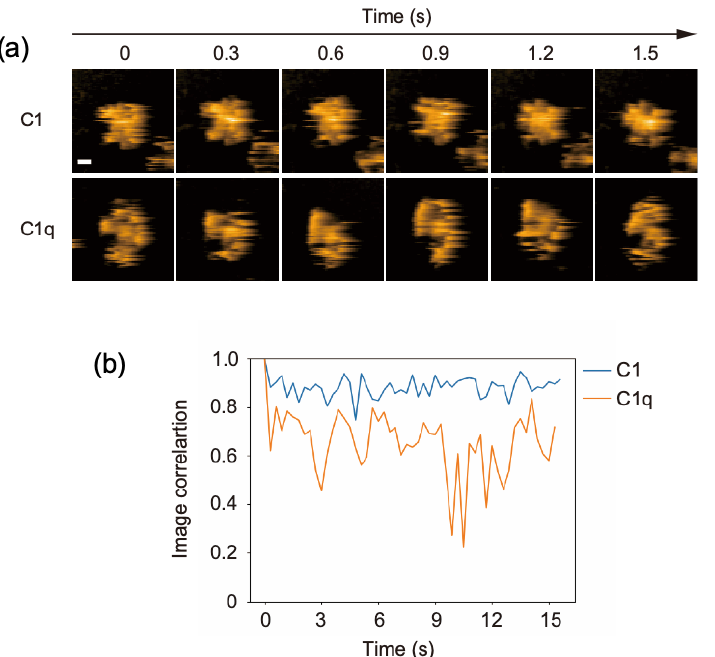
Figure 1. HS-AFM observation of C1 and C1q. ( a ) Clipped AFM images of C1 and C1q observed on the mica surface. Scale bar = 20 nm. ( b ) Time courses of the image correlation coefficient for C1 and C1q. The image correlation coefficient for each frame was calculated between the corresponding frame and the previous frame [19]. The larger fluctuation of the correlation coefficient for C1q than for C1 suggests that C1q has more structural flexibility.